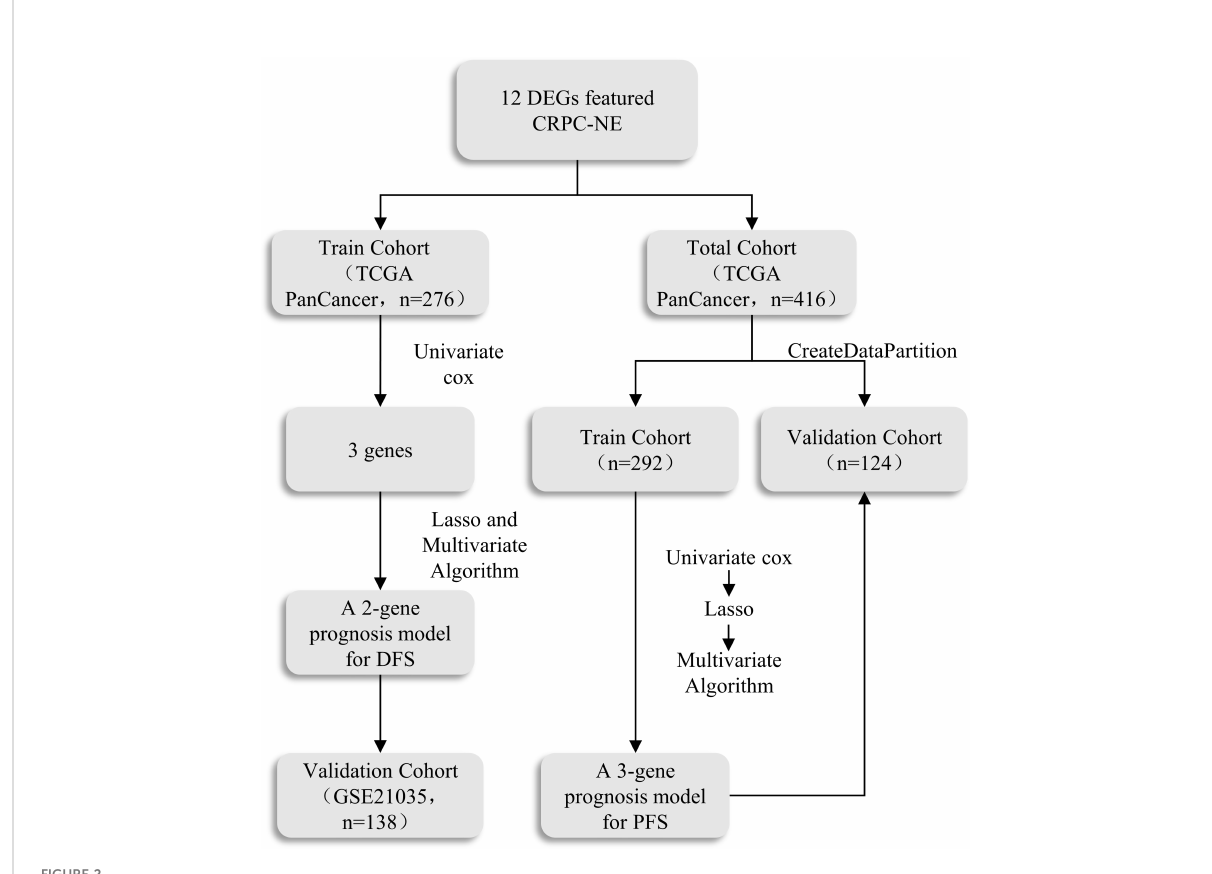
FIGURE 2 The scheme of the prognosis